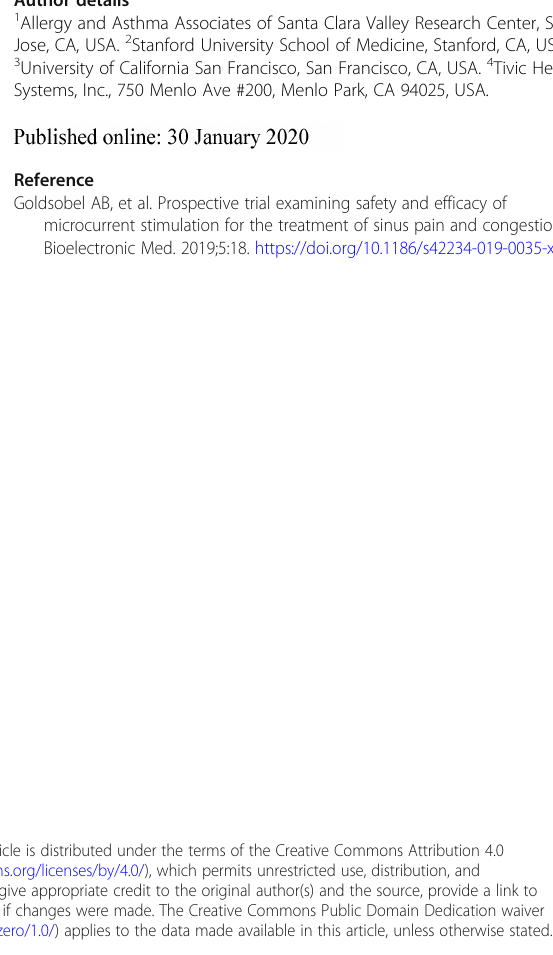
Figure 4 contained incorrect data. The correct number is marked bold and shown below: Daily microcurrent treatment reduces sinonasal con- gestion over 4 weeks. Sinonasal congestion was assessed weekly using the Congestion Quanitfier 7 (CQ7) instru- ment. Subjects that enrolled with moderate or worse congestion (CQ7 > 15, N = 24 ) exhibited significant re- ductions in congestion symptoms, compared to pretreat- ment, at all time points measured (a). Mean difference in CQ7 score from before treatment peaked at -8.8